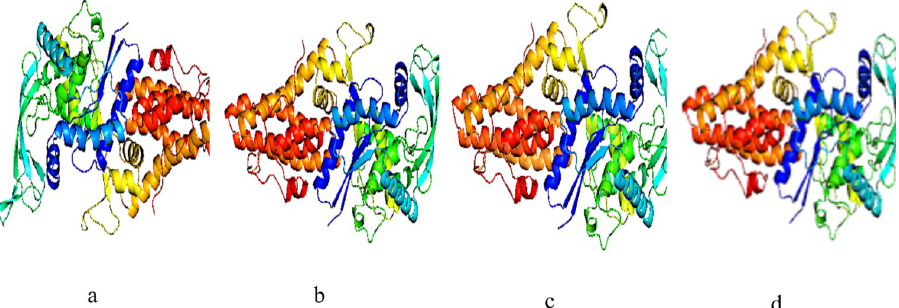
Fig 7. Cartoon model of the apo and holo forms of the target (after MDS). (a) BrMelMetRS (b) BrMelMetRS-OOU complex (c) BrMelMetRS-Isopteropodin complex (d) BrMelMetRS-Strophanthidin